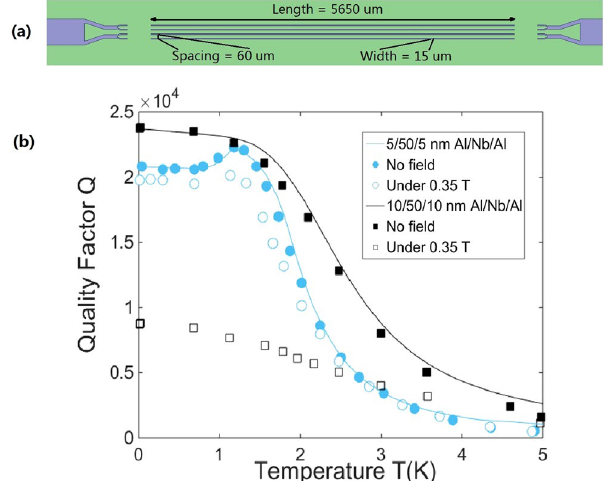
Figure 2. ( a ) Layout of the resonator device. It consists of four parallel λ /2 microstrip line resonators separated by 60 μ m . Each λ /2-resonator is 5650 μ m long, 15 μ m wide. ( b ) The Q values of 5/50/5 nm and 10/50/10 nm Al/ Nb/Al trilayer structures. The filled circles and squares are measured values for 5/50/5 and 10/50/10 Al/Nb/Al resonators without external fields; the empty circles and squares are measured values under a 0.35 T in-plane field. The solid lines are fitted curves from our